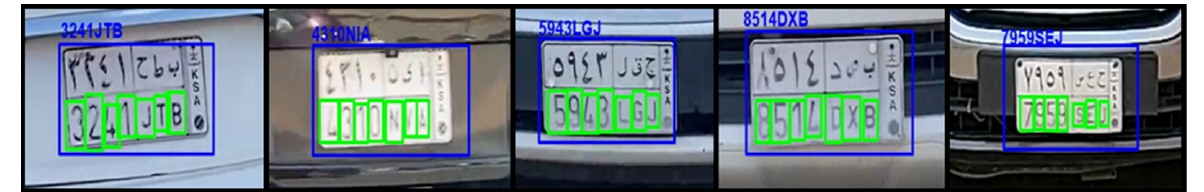
Figure 14. Recognition results under extreme visibility conditions.